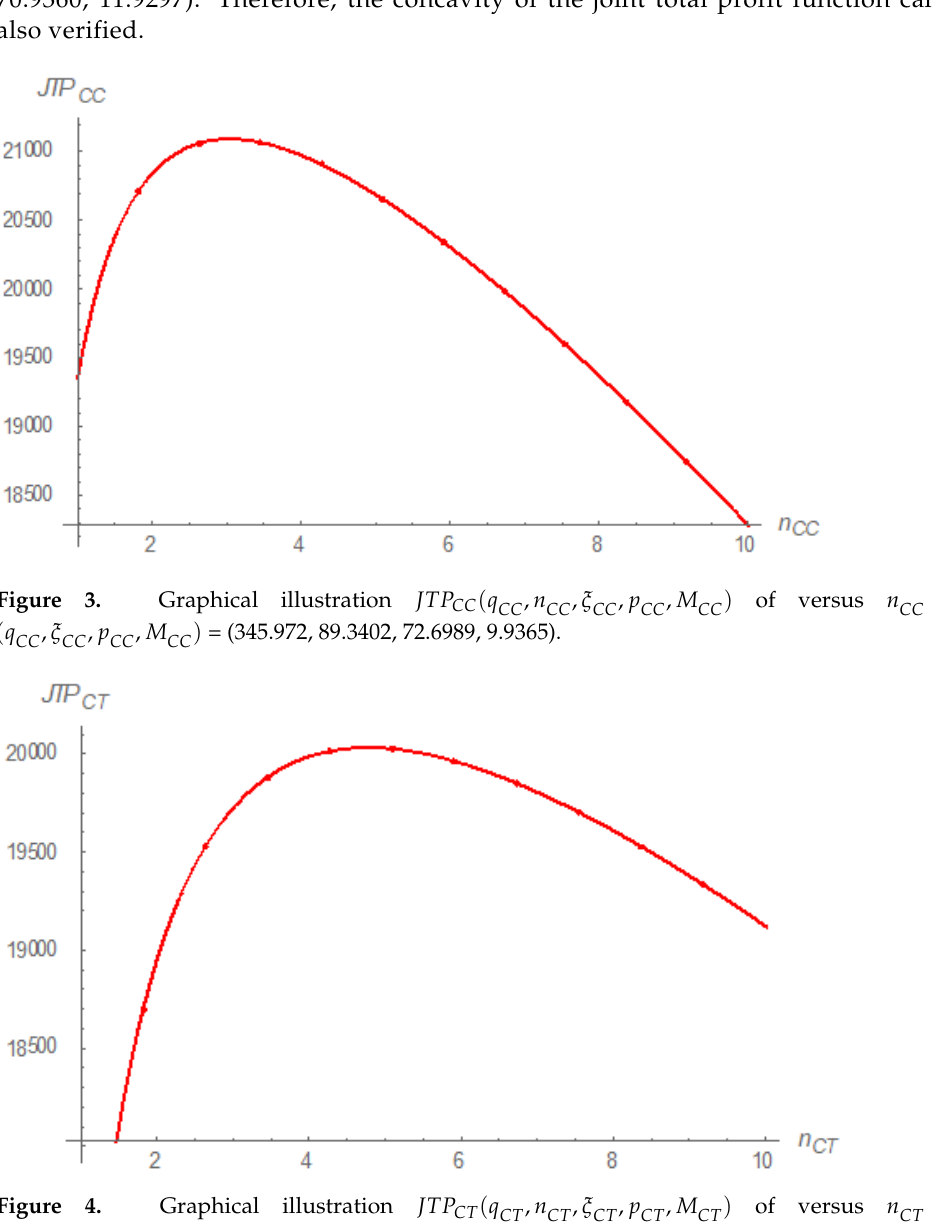
for CT n for CT